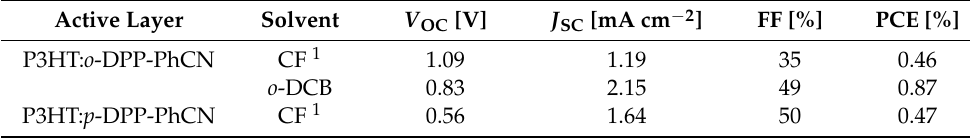
Table 1. Photovoltaic performances of the P3HT:DPP-PhCN binary cells. Active Layer